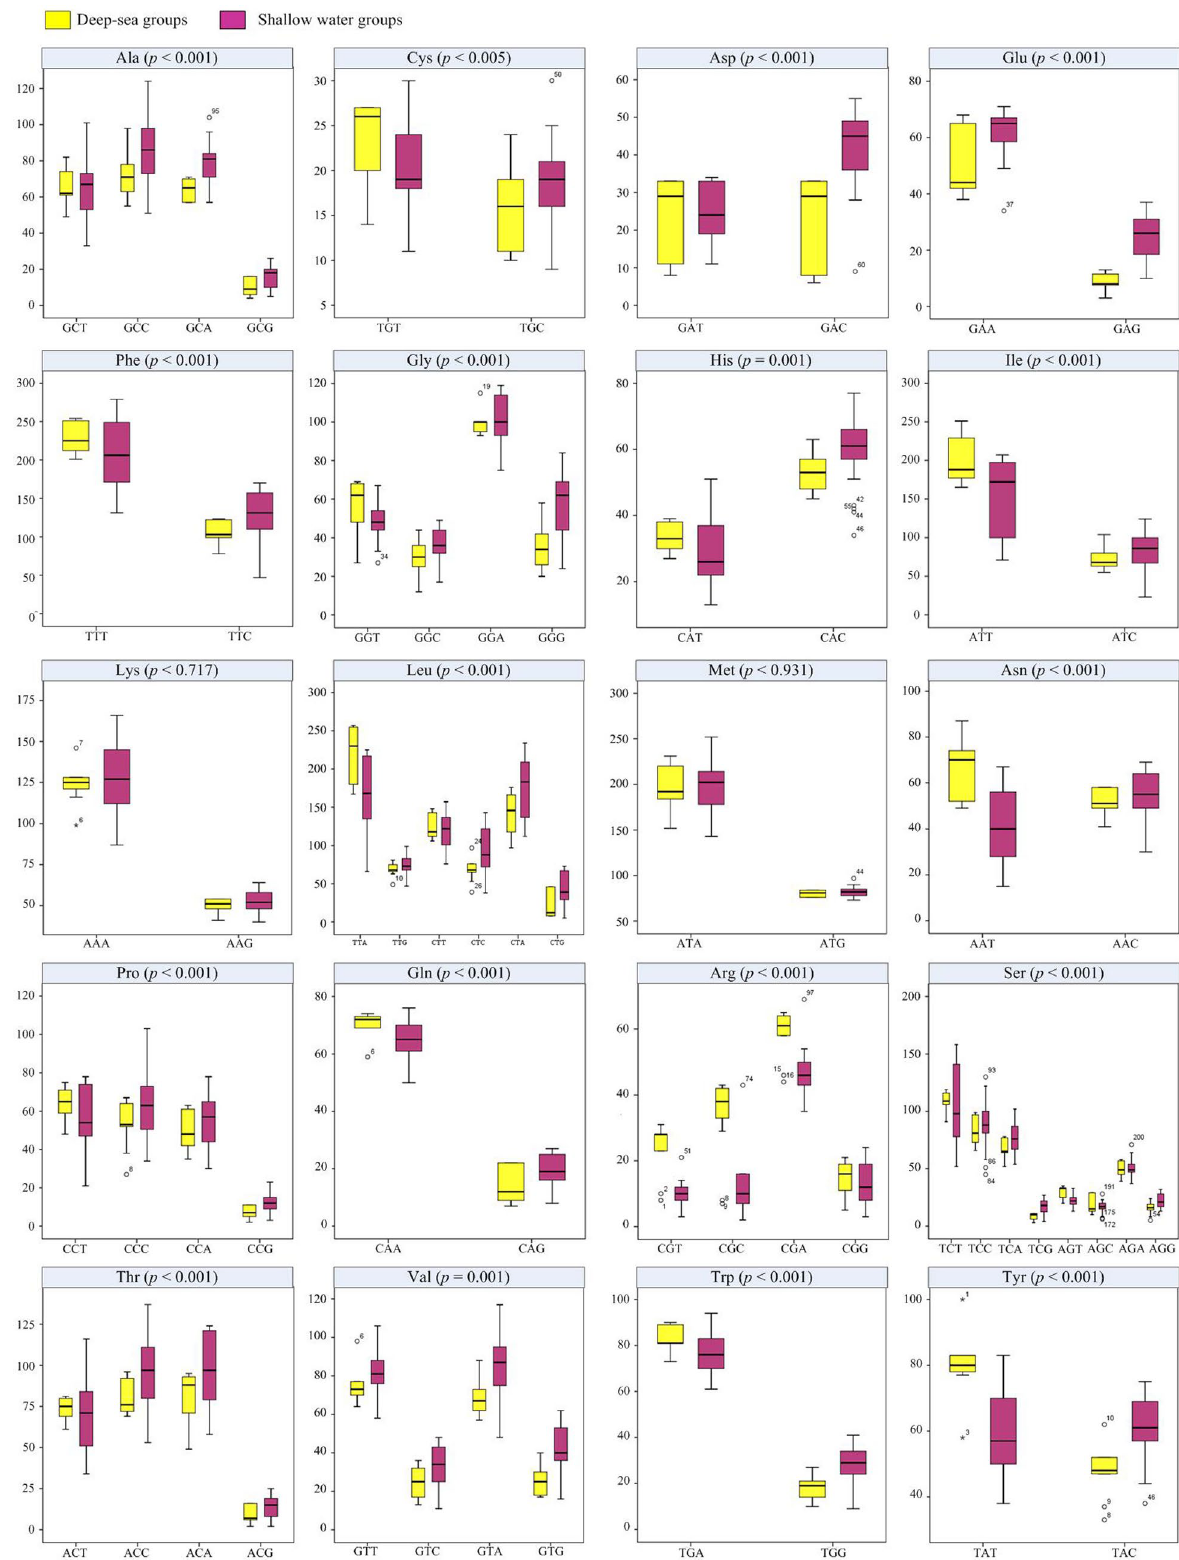
Figure 1. Comparisons of codon usage (y-axis) between the deep-sea and shallow water asteroids. x-axis indicated the synonymous codons. The amino acid and its corresponding p -value were shown at the top of each box